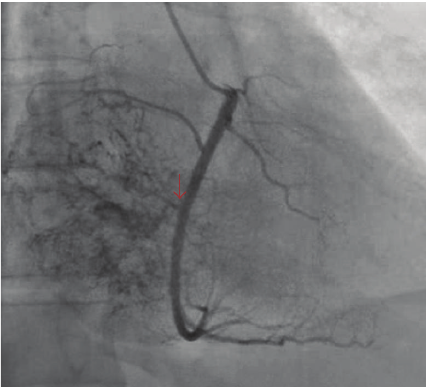
Figure 2: Angiogram demonstrating perfusion to the mass by a dense network of neovasculature arising from the mid right coronary artery.